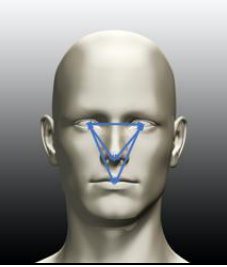
Figure 7. Triangles in [16].